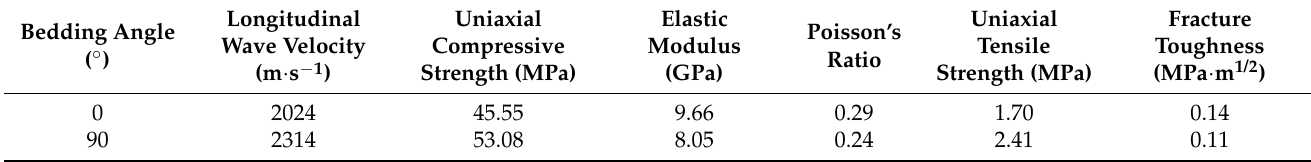
Table 1. Basic physical and mechanical parameters of sandstone